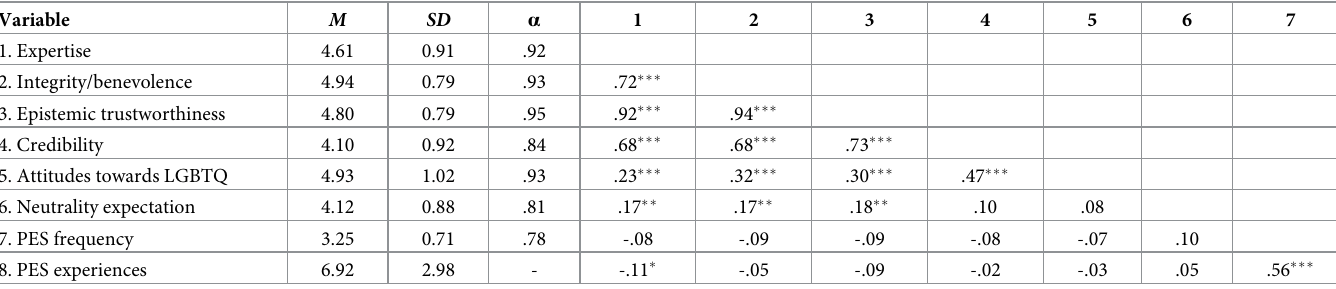
Note . N = 314. � indicates p < .05. �� indicates p < .01.